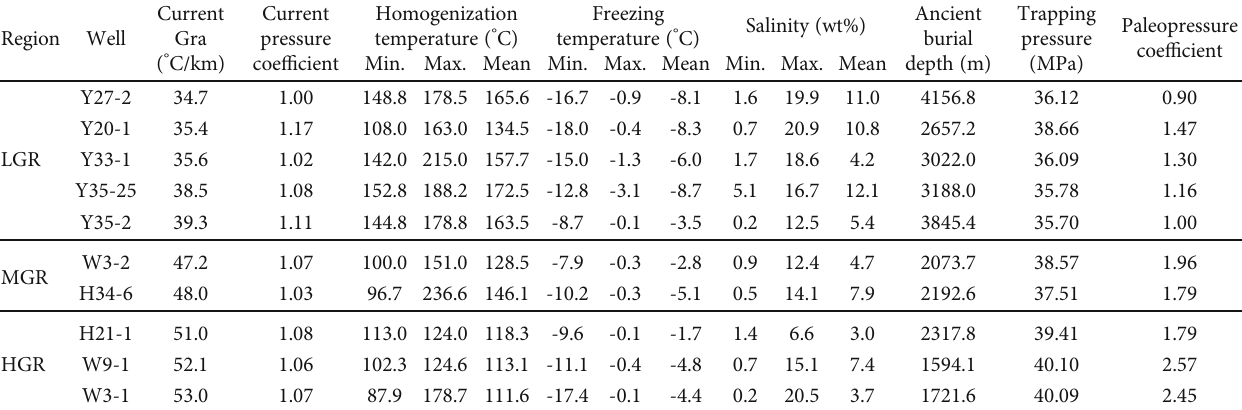
Table 2: Temperature, salinity, and trapping pressure of fl uid inclusions of sandstones in the Zhuhai Formation. Current Region Well Gra ( °